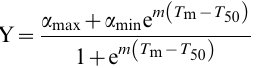
Figure S2 Fluorescence microscopy of cells exposed to apo and holoSOD1. Cells were visualized with immunocyto- chemistry, using DAPI for DNA staining (blue) and an anti-tubulin